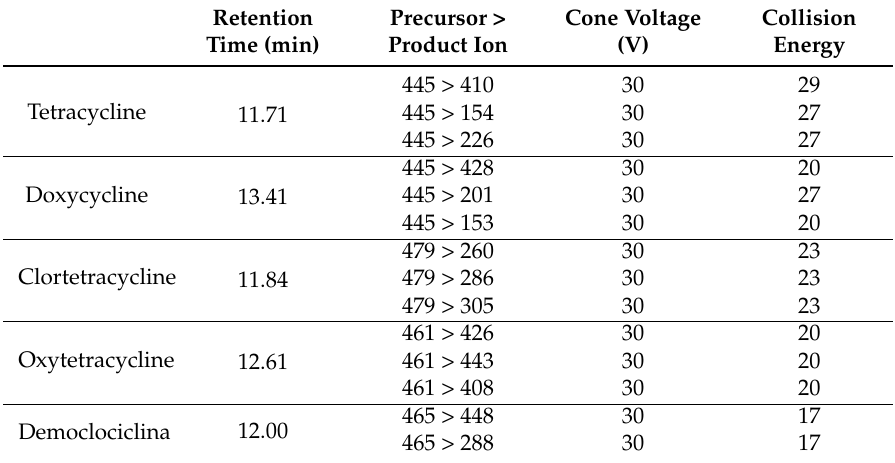
Table 1. Retention time, cone voltage, collision energy, precursor and product ions employed for ion